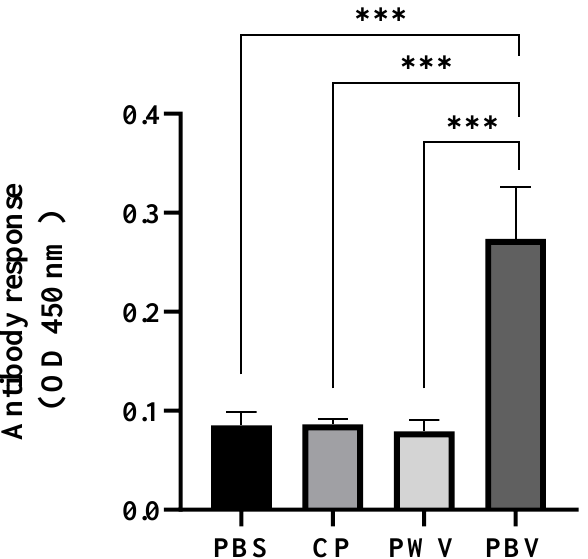
Figure 4. Serum specific antibody detection in vaccinated fish by ELISA. Serum IgM titers of giant grouper at 28 days after vaccination. Data are presented as mean ± standard deviation ( n = 4). The p -values were calculated by one-way ANOVA ( p < 0.001 ***). PBS: commercial feed with PBS. CP: commercial feed with chitosan particle. PWV: commercial feed with whole-cell vaccine. PBV: com- mercial feed with biofilm vaccine.